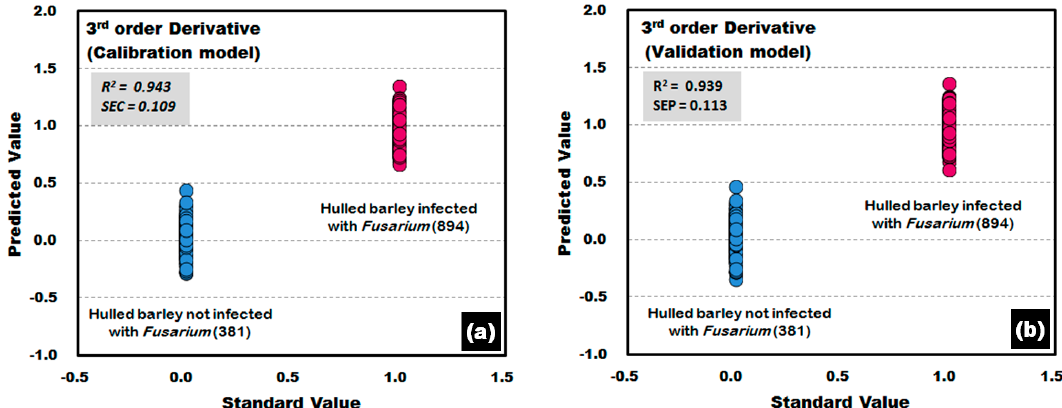
Figure 14. Fusarium discrimination calibration ( a ) and validation ( b ) results of PLS-DA model developed by applying the third-order derivative pretreatment to the reflectance spectra obtained from the front side of hulled barley.